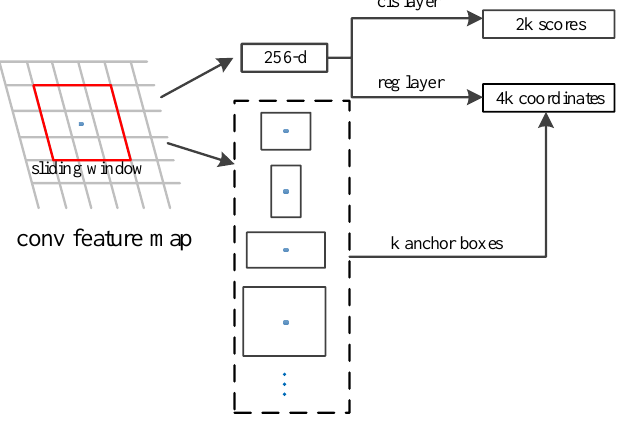
Figure 5. Region proposal